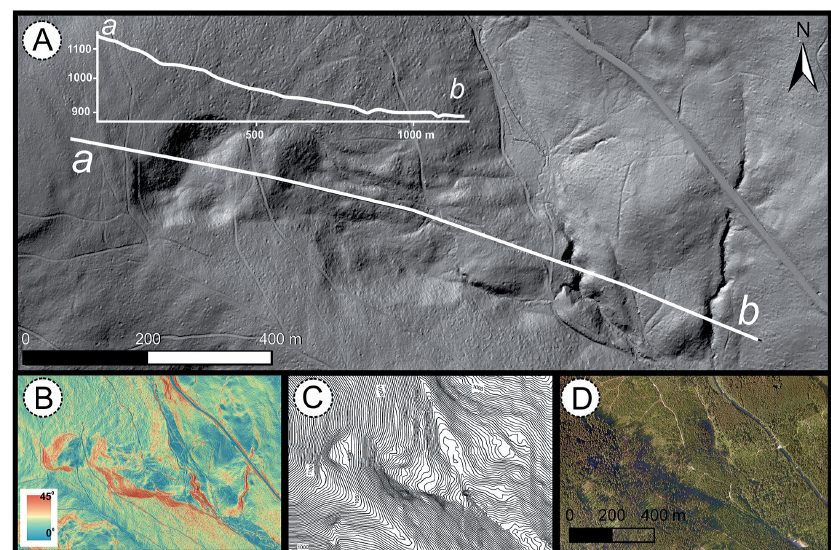
Fig. 10. Test area No 9. A – LiDAR image (a–b – topographic profile and its location), B – the map of slope reductions gen- erated from LiDAR (range of slope reductions is given), C – contour-line map, D – orthophotomap. Maps B–D at the same scale, Map A at larger